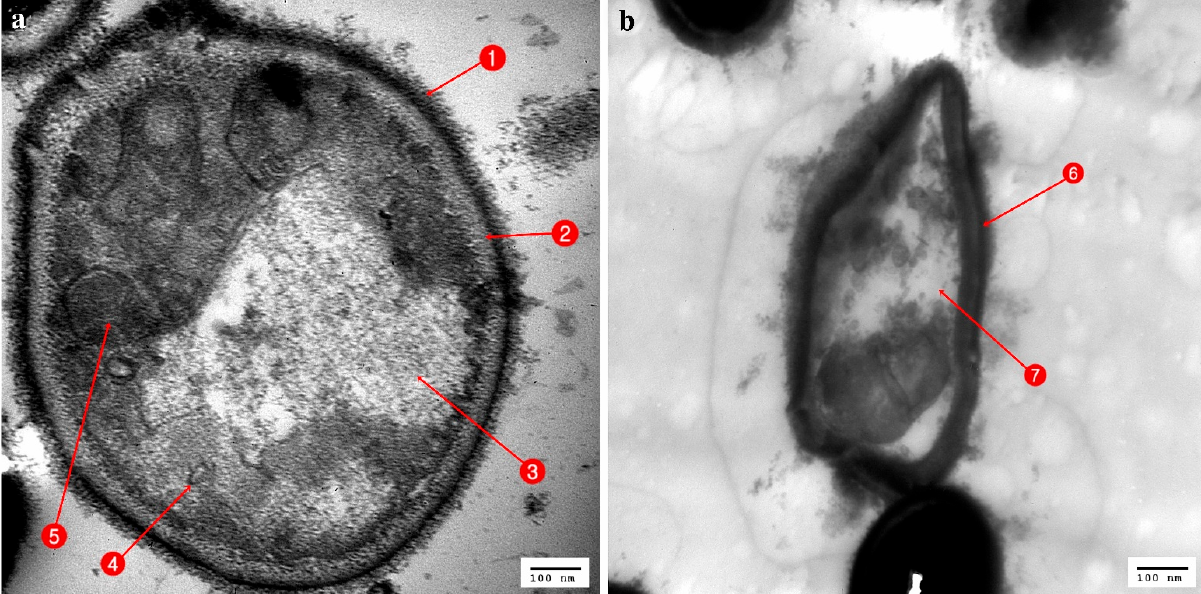
Figure 6. TEM micrograph of MRSA; ( a ) Normal cells: 1. Cell wall; 2. Cytoplasm; ( b ) cell affected with Serratia marcesens : 3. Shrinkage of cytoplasm; 4. Empty cell; 5. Leakage of cell material.